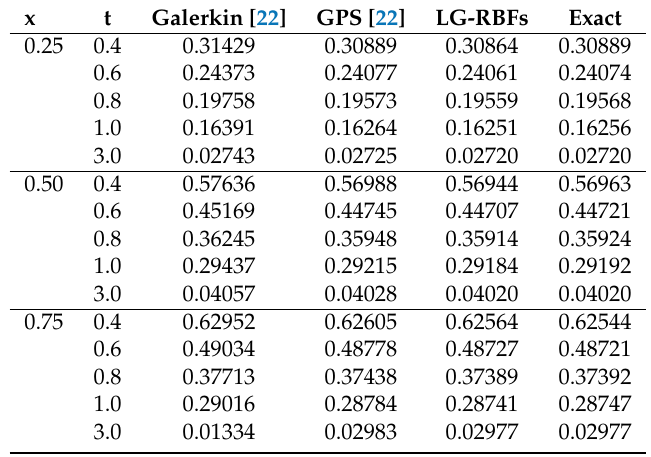
Table 2. Comparison of the approximate solutions at different final times with v = 0.1, M = 40 and ∆ t =